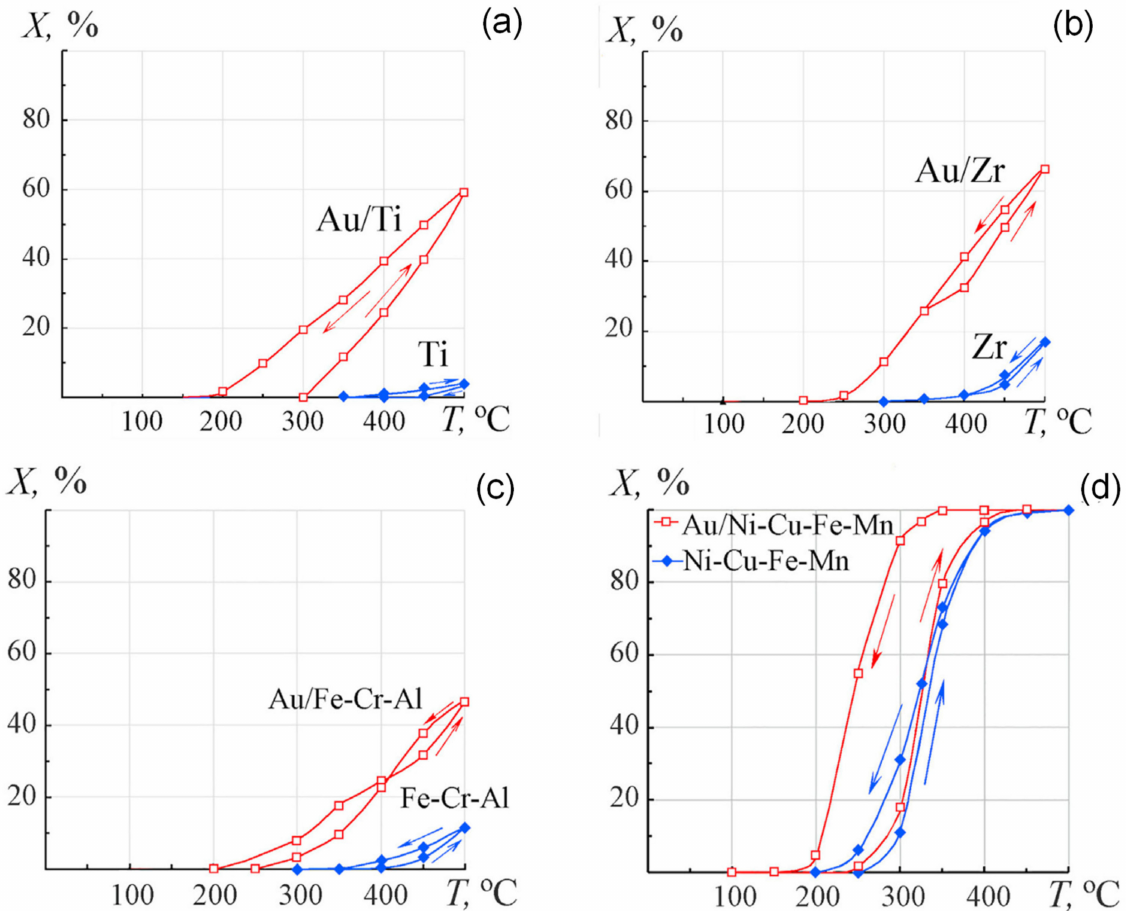
Figure 6. Temperature versus CO conversion in the first catalytic cycle over the samples of metal fibers from titanium ( a ), zirconium ( b ), Fe-Cr-Al alloy, ( c ) and Ni-Cu-Fe-Mn alloy ( d ) with and without a gold layer. ↑ = increase and ↓ = decrease in temperature (reproduced from Ref. [197]).